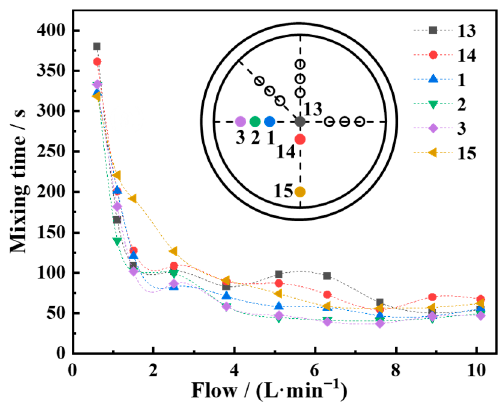
Figure 3. Blending time of different blowing rates in single hole